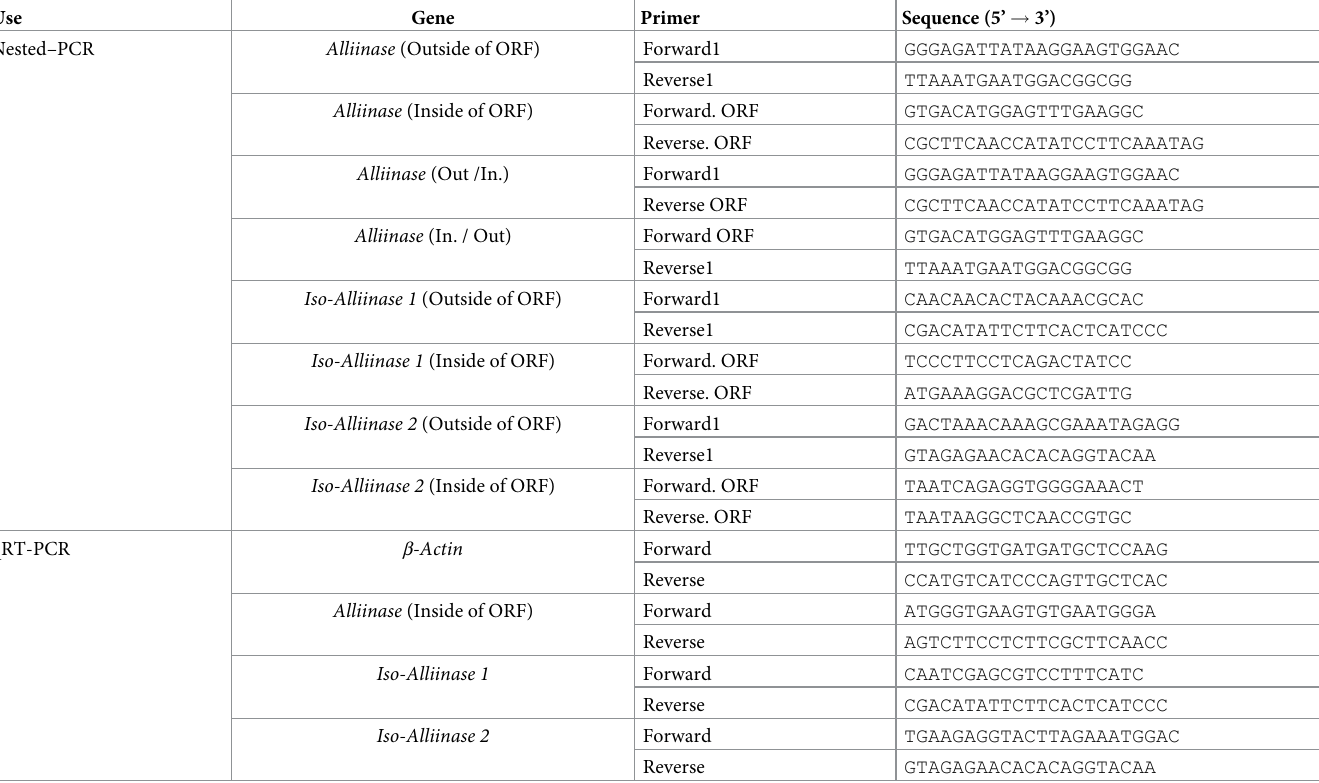
Table 4. Information and sequences of used primers in real time PCR and alliinase